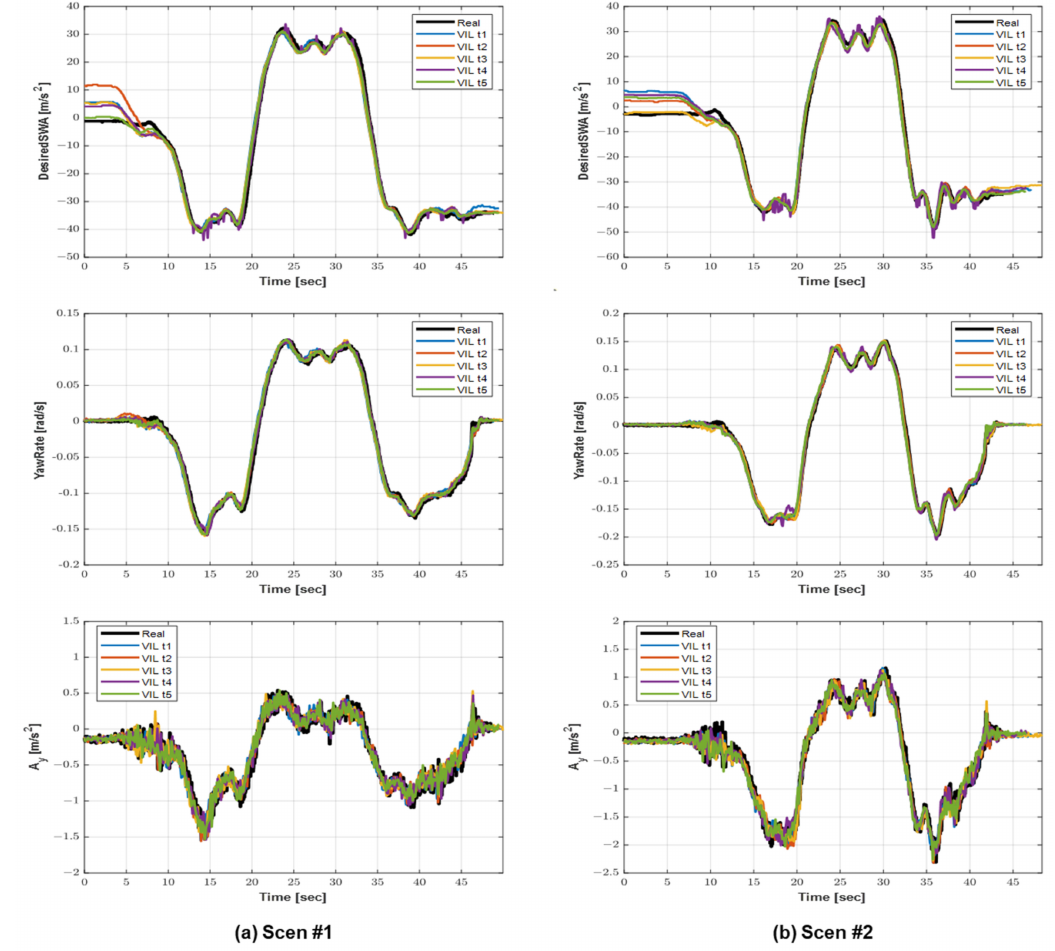
Figure 19. Results of Lateral behavior KPI. Table 6. Data Comparison Result—Lateral behavior (Desired steering wheel angle, Yaw rate, Lateral acceleration)